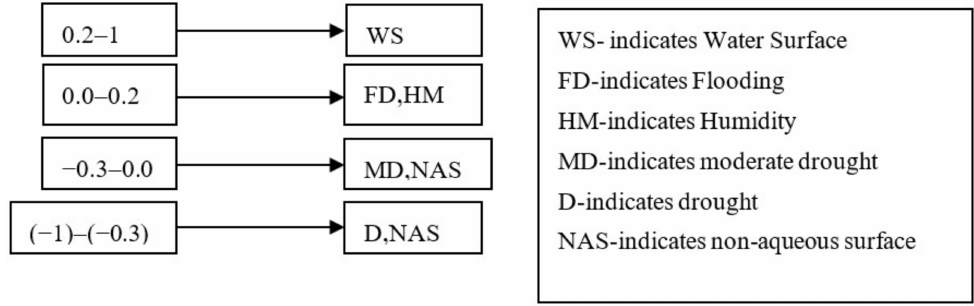
Figure 3. Detections corresponding to NWDI